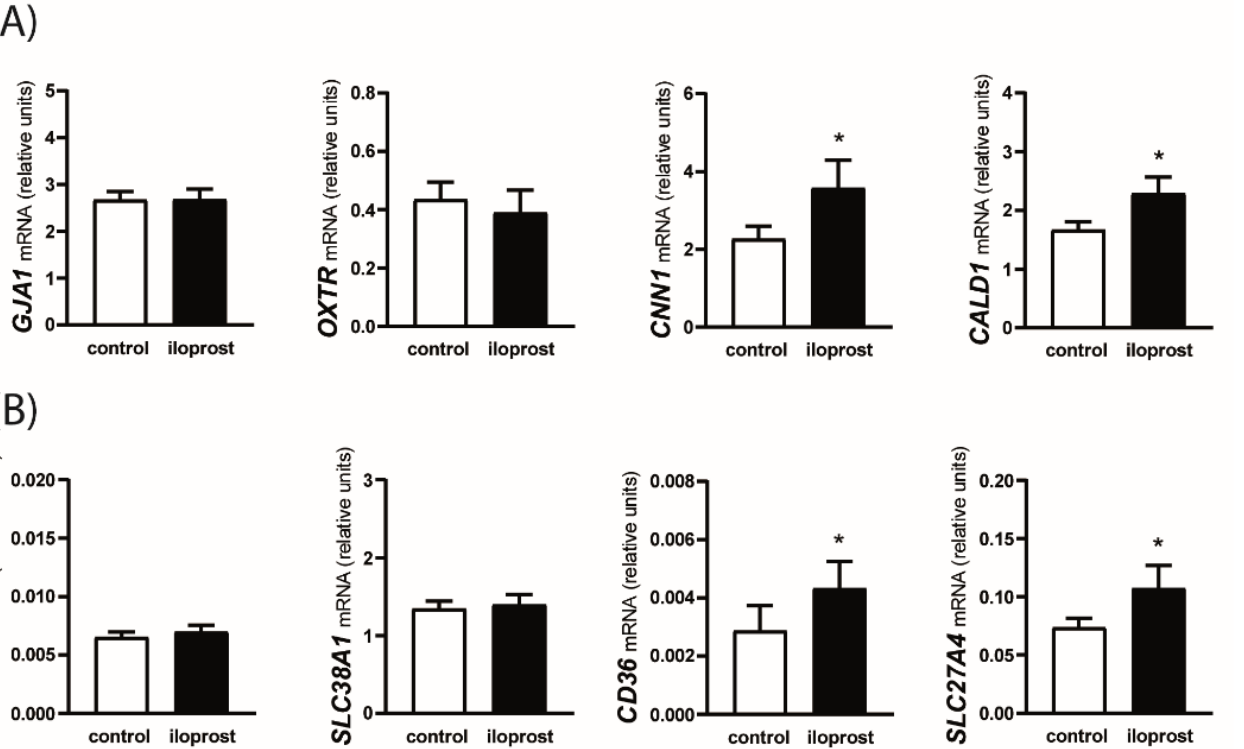
Figure 3. Effect of prostaglandin I2 (PGI2; prostacyclin) analog, iloprost, on the mRNA expression of contractility-related genes (panel A ; GJA1, OXTR, CNN1, and CALD1 ) and genes encoding trans- porters (panel B ) of glucose ( SCL5A1 ), amino acids ( SLC38A1 ), and fatty acids ( CD36 and SLC27A4 ) in the myometrium. Myometrial explants were incubated for 8 h without (control) or with 1 µM of iloprost. Values from real-time PCR for each studied mRNA transcript were normalized to geomet- ric averaging of GAPDH and HPRT1 mRNA expression. Data are expressed as the mean ± SEM ( n = 6). Asterisk specifies the difference compared with the control value (* p < 0.05).